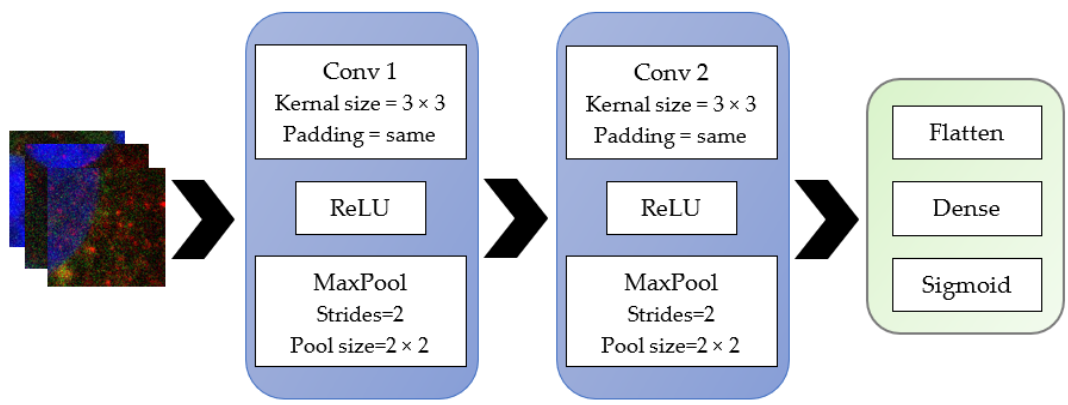
Figure 9. Model 2- sequential model’s layers.